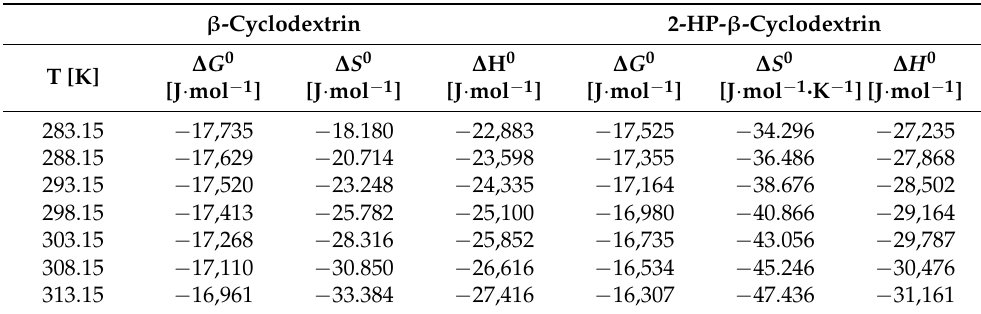
Table 6. The values of thermodynamic functions ∆ G 0 , ∆ S 0 , ∆ H 0 [J · mol − 1 ] for β -cyclodextrin and 2-HP- β -cyclodextrin with the salt of trans – p -coumaric acid.